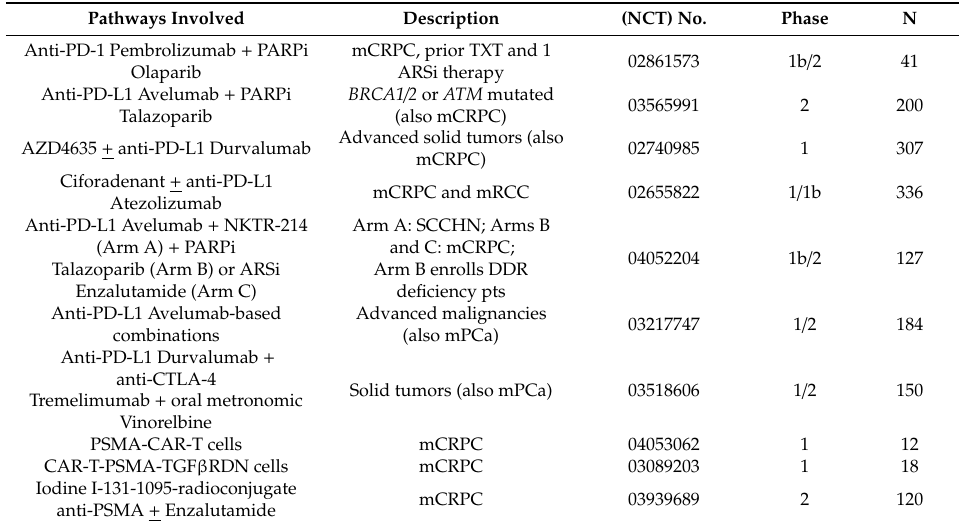
Table 3. Ongoing clinical studies with novel molecules / combinations.